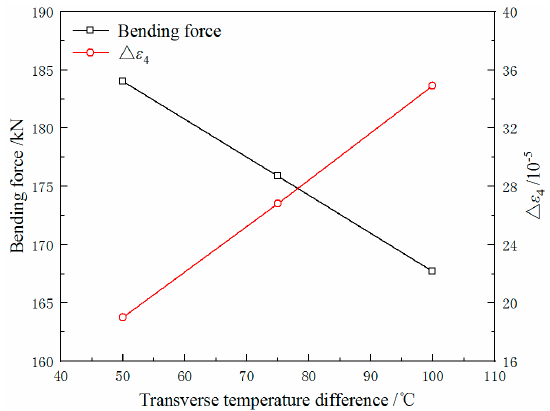
Figure 15. Bending force and Δ ε 4 of the strip with different values of Δ T .